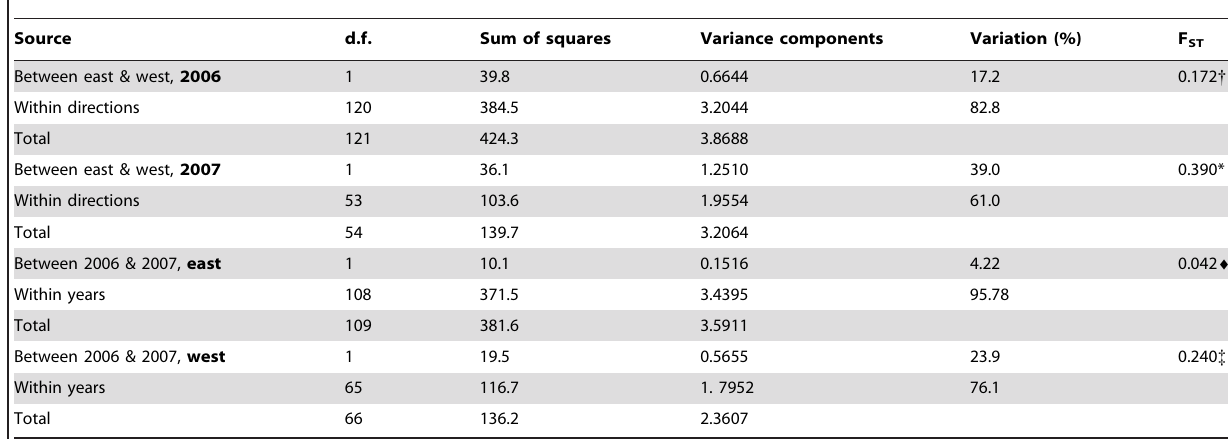
Table 1. Analysis of molecular variance using mtDNA CO1 haplotypes.